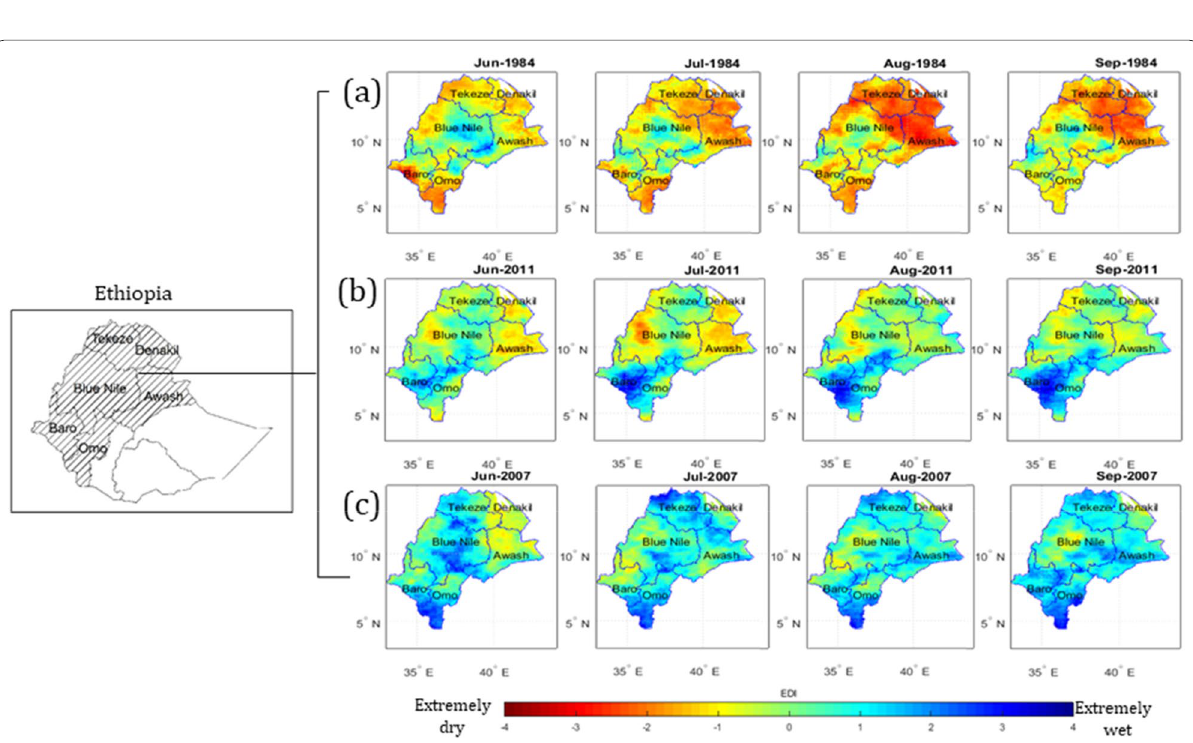
Fig. 7 Spatial pattern of the monthly EDI values in the selected river basins during main rainfall months in ( a ) 1984 drought year ( b ) 2011 drought year and ( c ) 2007 non-drought